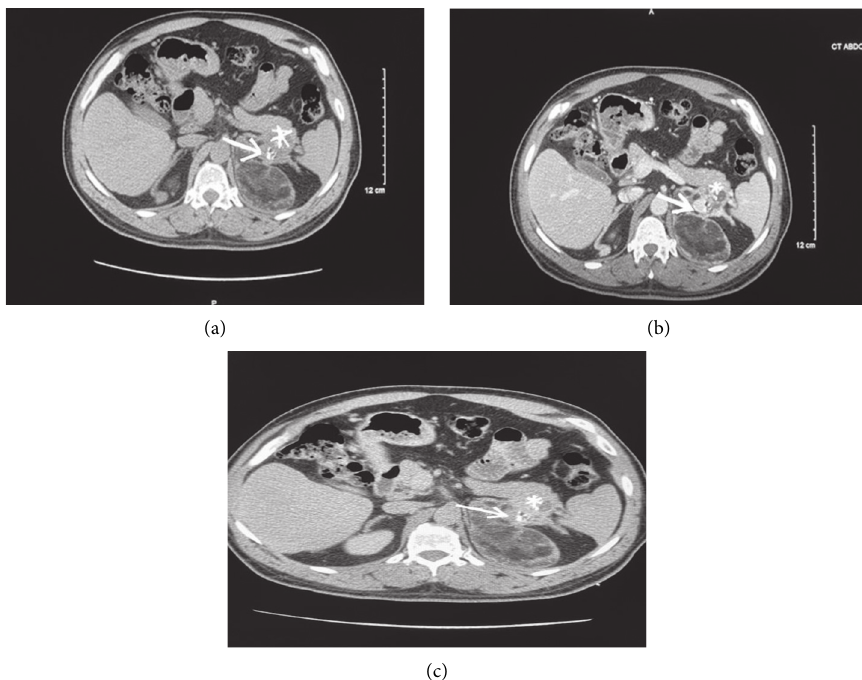
Figure 2: A multiphase CTwith noncontrast (a), contrast (b), and delayed (c) images demonstrating the enhancing solid component of the left adrenal mass (arrow) and the region of questioned pancreatic invasion